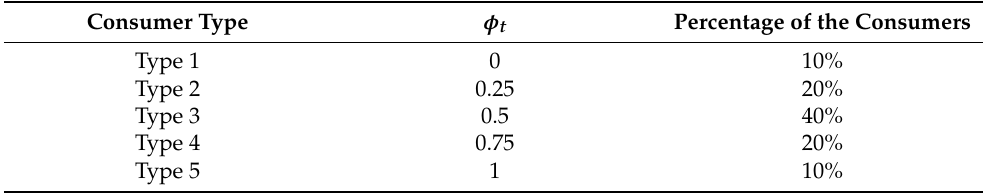
Table 2. Different types of consumer quality